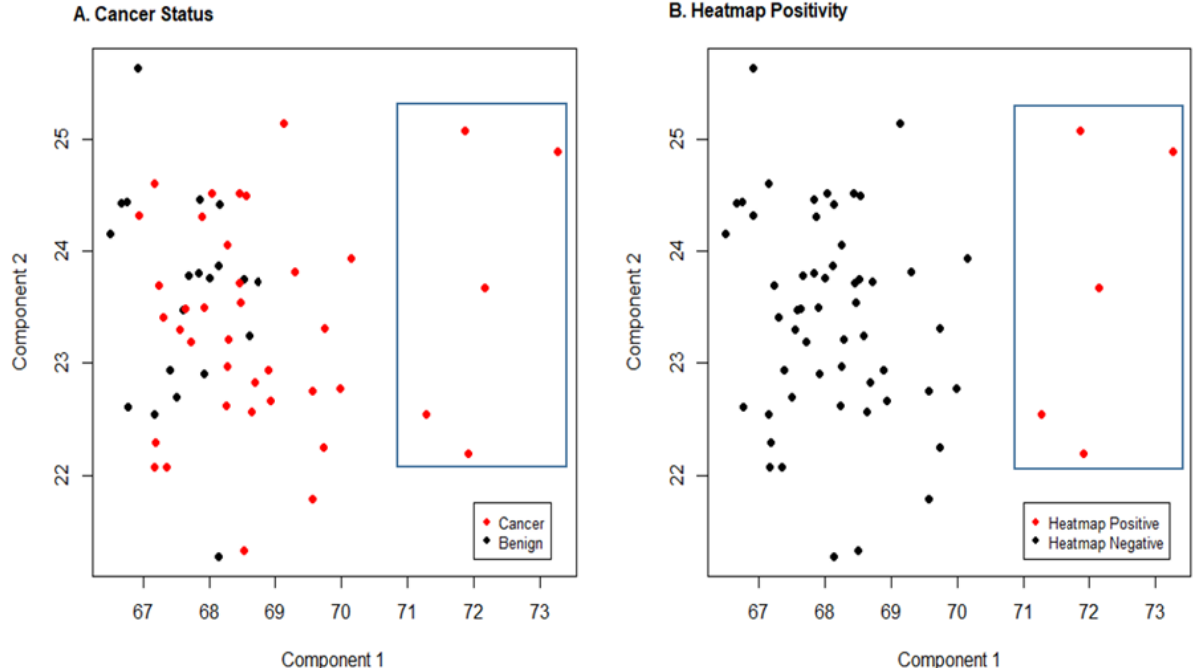
Figure 9. Sparse principal component analysis. Scatter plots of principal component 1 by component 2 from the sparse principal component analysis. ( A ) denotes values of these components by cancer status (red = cancer, black = benign). ( B ) denotes the 5 extreme patients identified by the heat map (Figure 7) in red versus all others in black. The blue rectangle in both plots highlights these five patients.